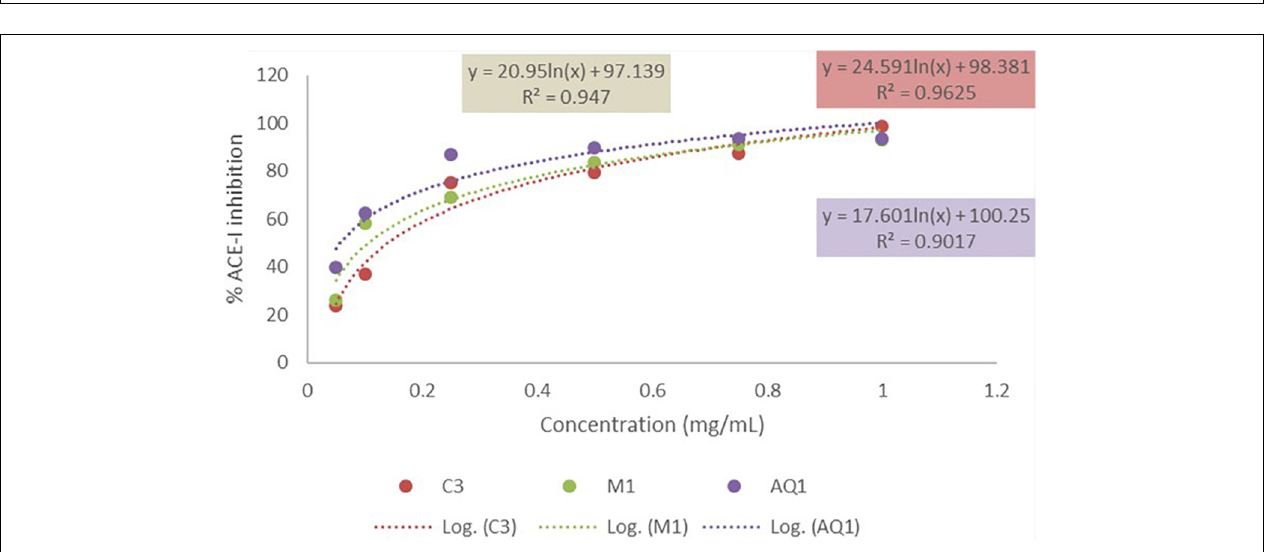
FIGURE 4 | (A,B) Acetylcholine-esterase enzyme (AChE) inhibition by mesopelagic Hydrolysates generated from Krill (K), M. muelleri (M), and a combination of both and aqueous extracts (AQ) ( n = 3). One way ANOVA was done using Tukey’s multiple comparison test at α = 0.05, where all the aqueous extracts (AQ) gave significantly less inhibition when compared to the positive control inhibitor acotiamide dihydrochloride. Amongst the Hydrolysates inhibition differences have been included on the graph.